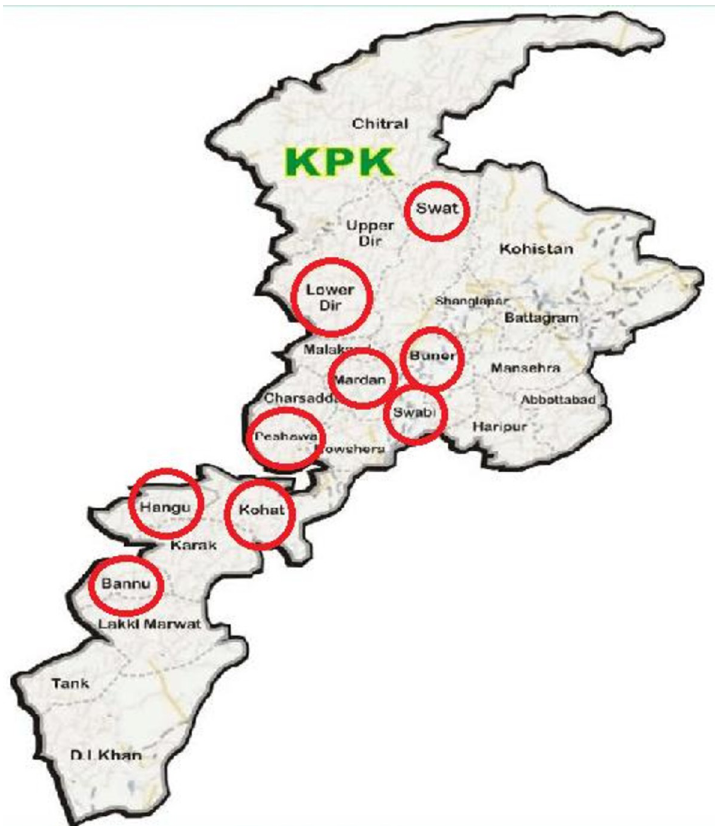
Fig 1. Map of Khyber Pakhtunkhwa showing different districts of study (encircled). Source: Pakistan travel forum; http://www.pakistantravelforum.com/threads/khyber-pakhtunkhwa-kpk.64/.